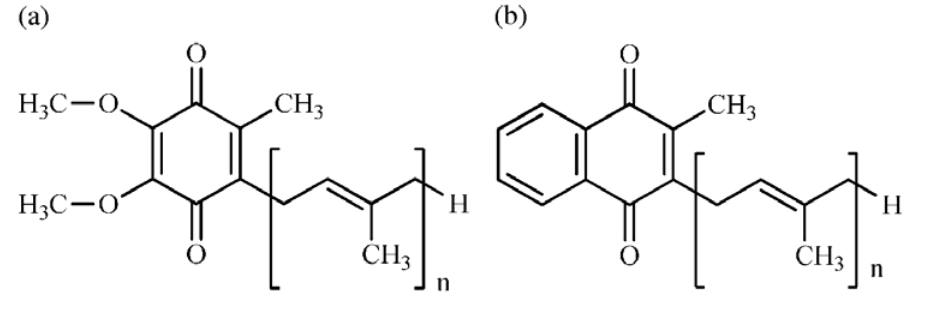
Figure 1. Chemical structures of ( a ) ubiquinone (UQ-n (Hx)) and ( b ) menaquinone (MK-n (Hx)), where n is the length of the isoprene unit of the side chain and x is the number of hydrogens atoms saturating the double bonds of the isoprene